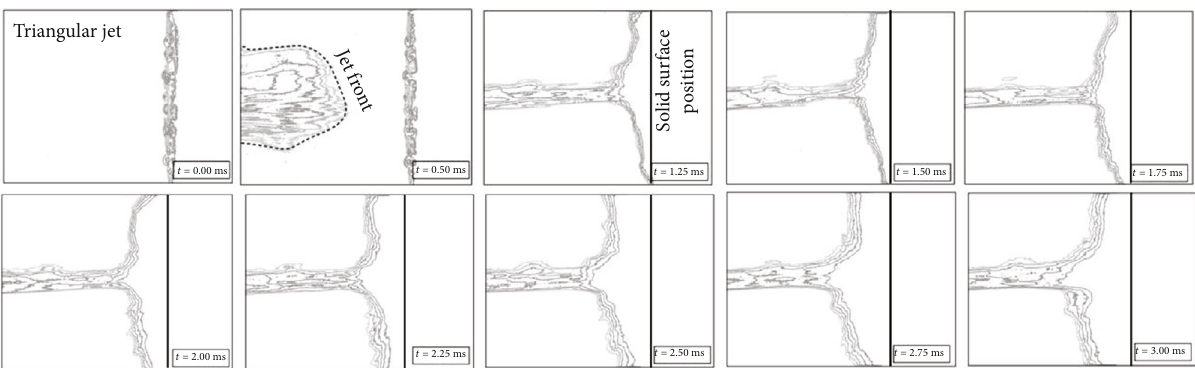
Figure 8: The evolutions of a triangular jet impacting a solid